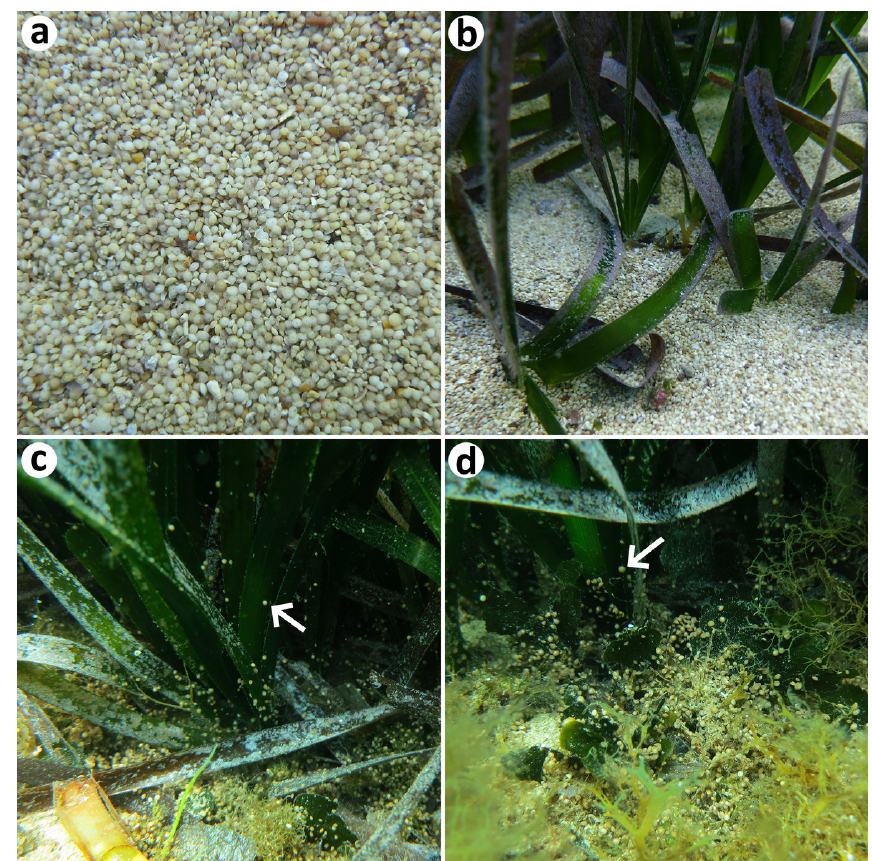
Figure 2. Substrate and epiphytic communities of the invasive foraminiferan Amphistegina lobifera investigated in this study. (a) In situ view of the investigated seabed substrate containing numerous A. lobifera specimens; (b) leaves of the seagrass Posidonia oceanica being buried in the substrate containing numerous A. lobifera specimens; (c, d) epiphytic specimens of A. lobifera occurring on the leaves of P. oceanica (arrows) and the surrounding seaweeds. All photos taken by Martin